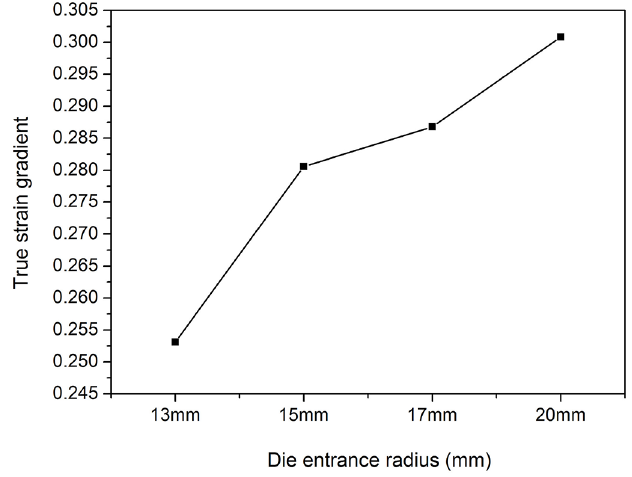
Fig. 11. True strain gradients between the external and the internal surface at the cup wall of square cups under various die entrance radii.